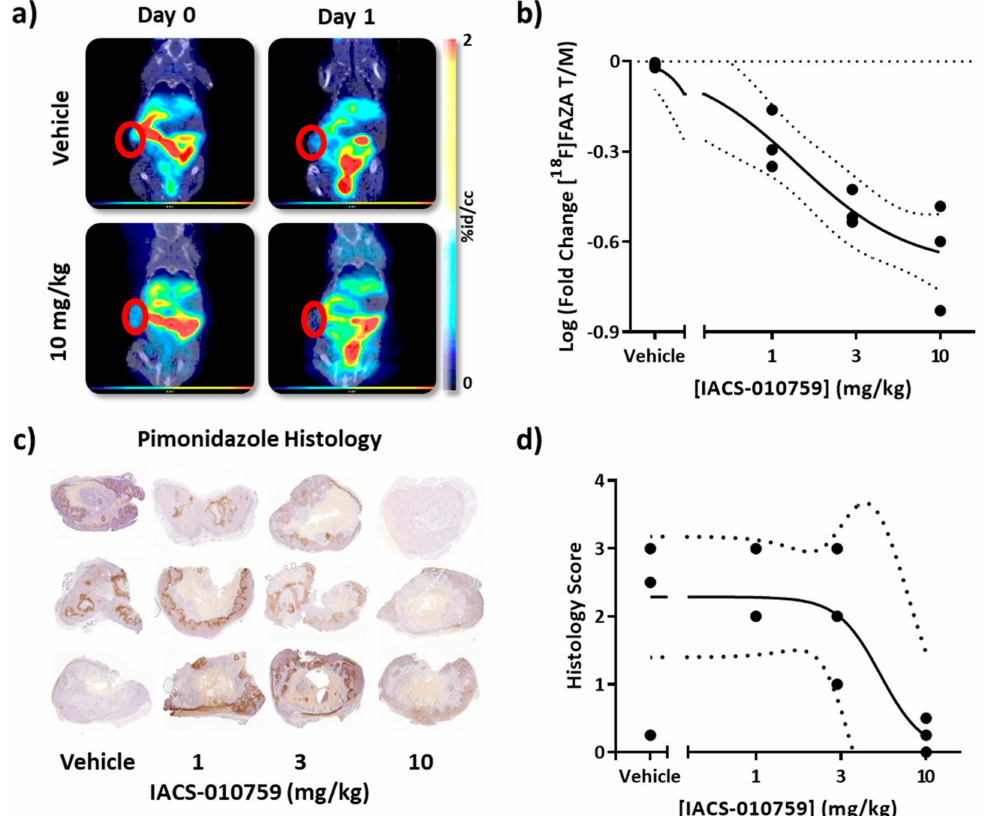
Figure 6. [ 18 F]FAZA retention by PET / CT yielded a quantitative IC 50 value similar to histological markers of hypoxia but with enhanced precision in the A375-R1 melanoma model. BRAF inhibitor-resistant A375-R1 tumors were grown subcutaneously and imaged with [ 18 F]FAZA PET / CT. After baseline imaging (Day 0), mice were treated with vehicle or 1, 3, or 10 mg / kg IACS-010759 p.o. and 24 hrs later re-imaged (Day 1). Moreover, 3 h prior to euthanasia, all mice were injected with pimonidazole HCl (60 mg / kg) i.p. and tumors processed for IHC. ( a ) Example coronal images of mice treated with vehicle or IACS-010759 (10 mg / kg) from Day 0 and Day 1. ( b ) PET / CT data were quantified, log fold-change in T / M plotted vs. delivered dose, and fitted to a four parameter dose-response curve. ( c ) Pimonidazole IHC slices from all twelve mice were scored by an independent pathologist. ( d ) IHC scores were also fitted to a four parameter dose-response curve yielding similar IC 50 values, but less precision (dotted lines indicate 95% CI of the